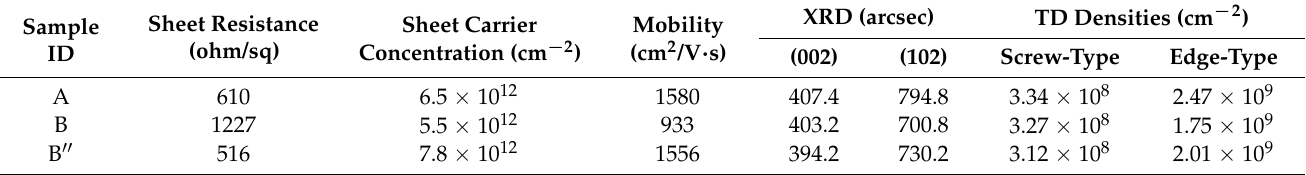
Table 1. Dependence of Hall, XRD measurements, and TD densities on different GaN:Fe